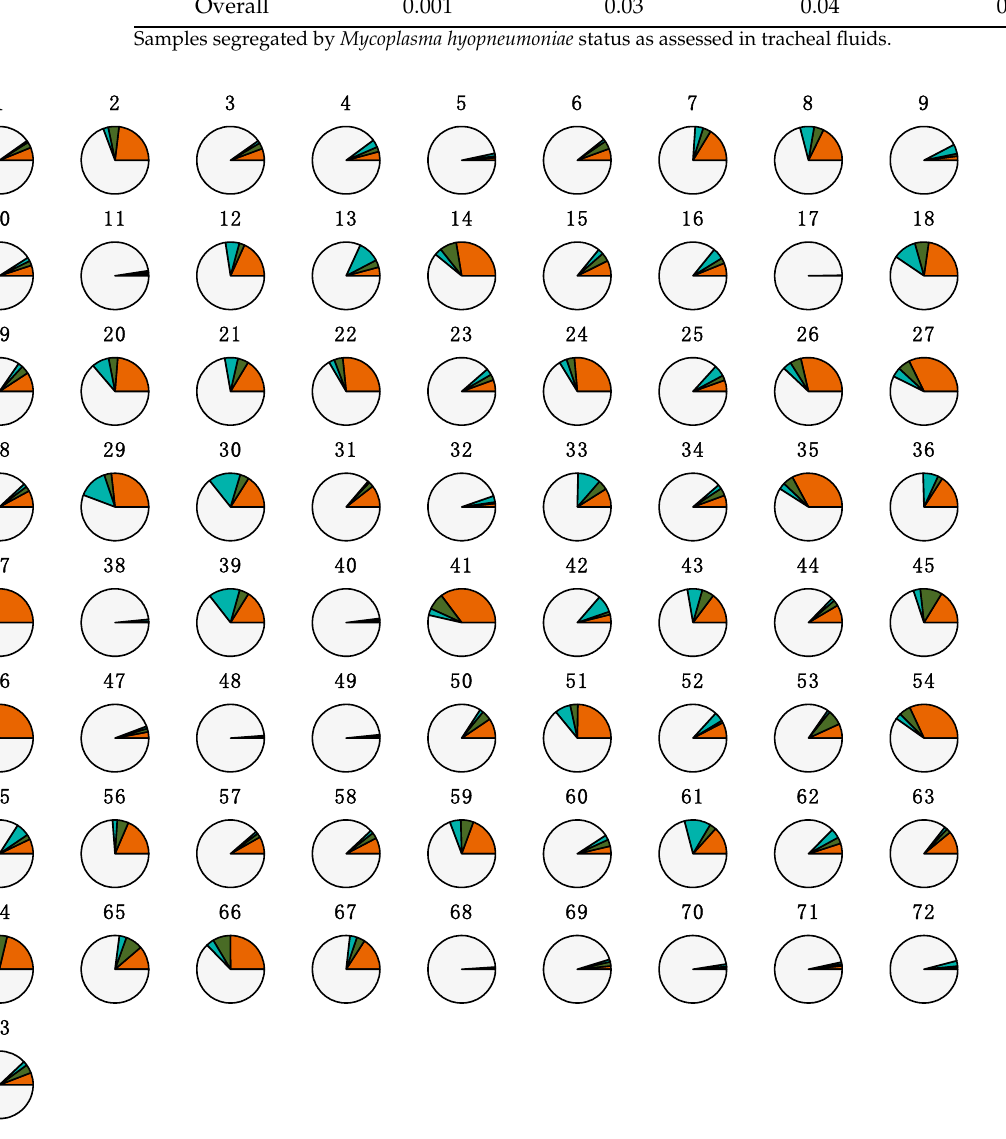
Figure 5. Proportions of the tracheal fluid microbial community potentially originating from fecal, air, or oral fluid sources. Each pie represents the tracheal fluid of one individual pig (n = 73). Sources are color-coded. Orange: air; green: feces; teal: oral fluids; light gray: unknown. Table 4. Characteristics of the distribution of the proportions of tracheal fluid microbial communi- ties potentially originating from fecal, air, or oral fluid sources.